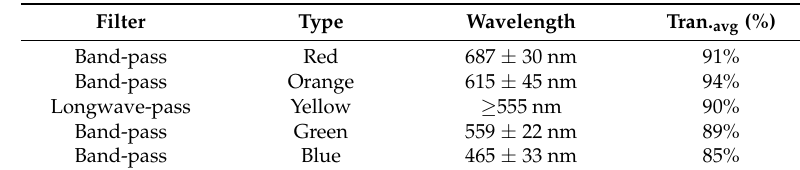
Table 1. Characteristics of the optical filters in the light source.